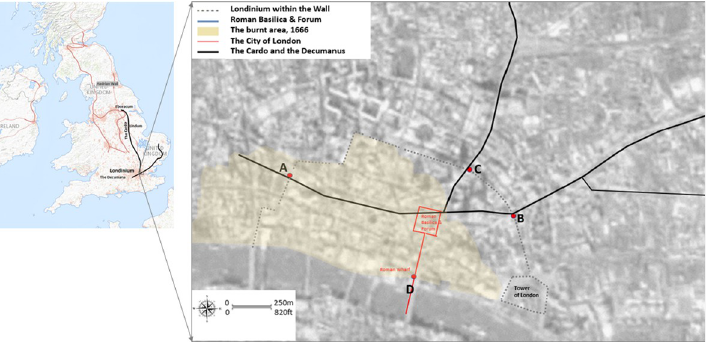
Fig 1. Patterns of the Roman occupation in today’s London: (a) The Roman Occupation of Britain and the location of significant settlements and roads during this period; (b) The Roman Londinium and the Burnt area of medieval City of London 1666 (inside the old Roman city wall) superimposed on a modern Google map to describe the connectivity of our case study. Note that since the Roman times the river has been embanked and so the wall’s line on later maps is seen to be slightly inland (https://landsat.visibleearth.nasa.gov/view.php?id=78669 and https://apps.nationalmap.gov/ viewer/).